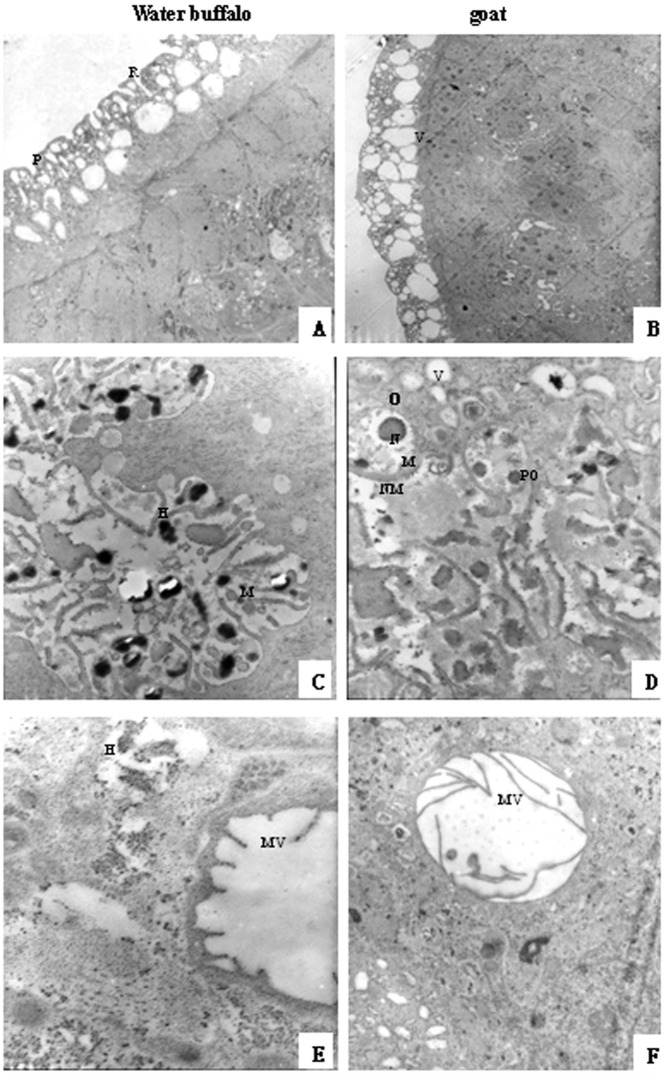
Comparisons of the female worms derived from water buffalo and goats by TEM.(A, B) tegument, 2000× magnification; (C–F) subtegument and inner structure, 12,000× magnification. H, heterochromatin; M, mitochondria; O, oogonia; N, nuclei; NM, nuclear membrane; PO, primary oocytes.